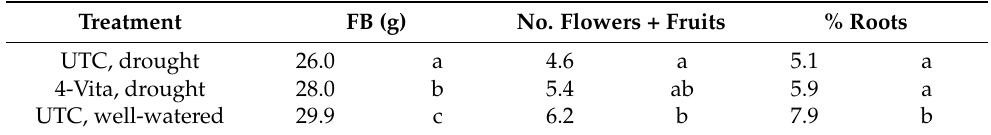
Table 4. Assessments at 14 DAR of shoot biomass (FB, g), flowers and fruits, and on % of roots on the remaining plants. For each trait, at least one letter in common indicates no significant difference.